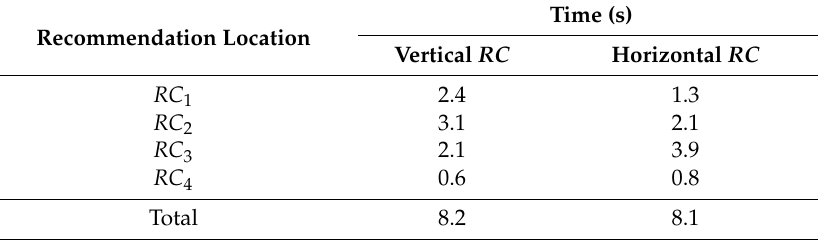
Table 1. Average fixation time(s) for each recommendation location.